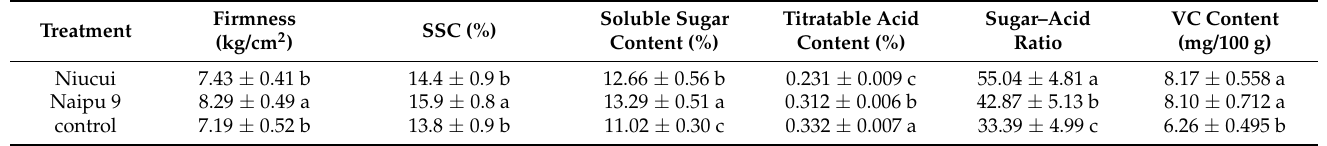
Table 2. Effects of spraying calcium fertilizer on the internal quality of apple